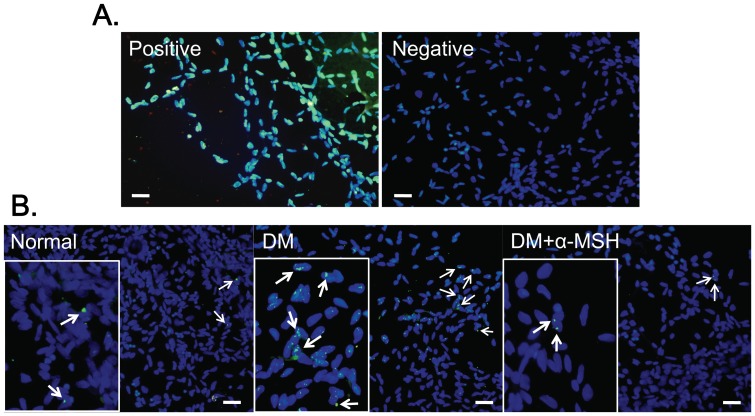
α-MSH administration substantially reduced the number of apoptotic cells in the trypsin-digested diabetic retina preparation.TUNEL staining images were merged with those of DAPI counterstaining. The positive and negative controls for TUNEL staining are shown in (A). The TUNEL staining images of normal control (normal), diabetes (DM), and diabetes with α-MSH intervention (α-MSH+DM) are shown in (B); the insets are the amplified portion of the images for better visualization. n = 8/group, scale bar, 20 μm.